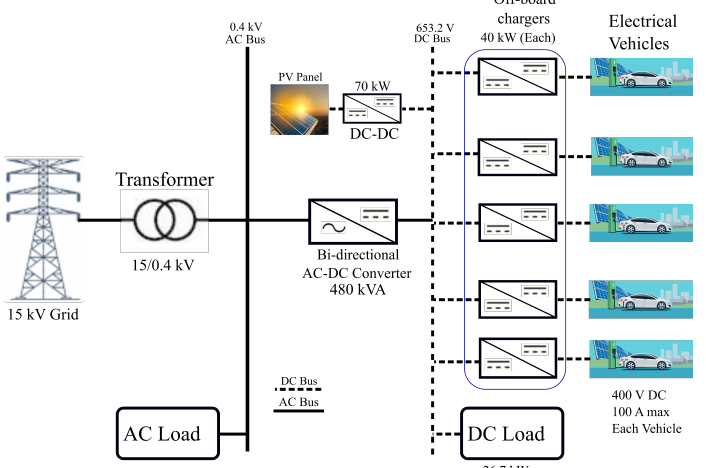
Figure 1. Illustration of microgrid that involves the vehicle simultaneous charging–discharging [21], © 2021